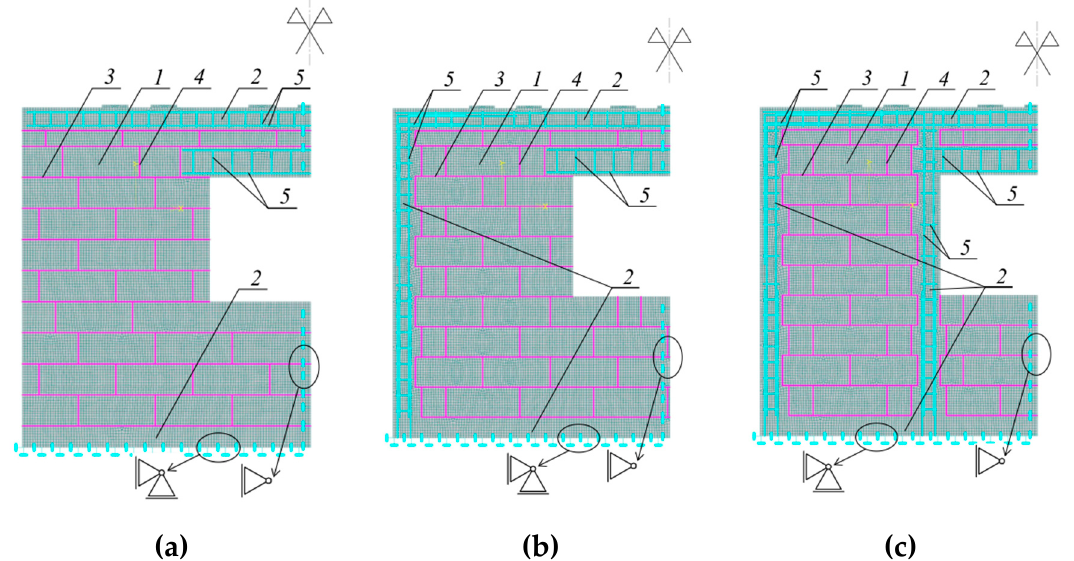
Figure 17. Numerical models of walls used in FEM calculations for the following series: ( a ) model of MNSO wall, ( b ) model of MSO wall, ( c ) model of M2SO wall: 1 —masonry units with the elastic-plastic based M-W-3 model, 2 —reinforced concrete elements with the elastic-brittle based model, 3 —contact elements in bed joints, 4 —contact elements in head joints, 5 —finite elements representing reinforcement with the H-M-H model.